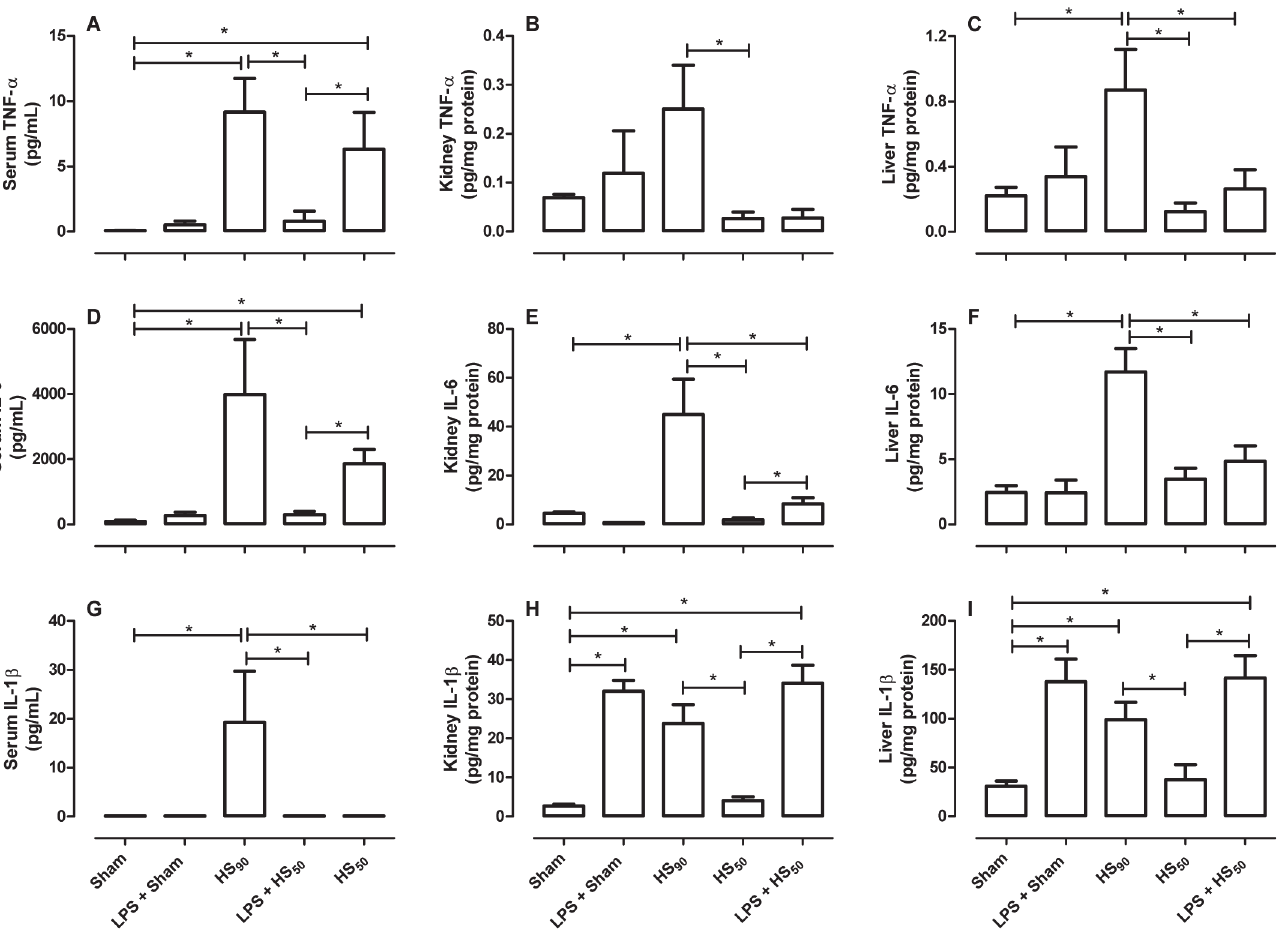
Fig 6. Effect of LPS preconditioning on cytokines production. Rats were injected vehicle (PBS) or LPS (1 mg/kg) i.p. 24 h prior to HS 90 or HS 50 . Sham animals were used as control. Four hours after resuscitation, serum (A, D, G), kidney (B, E, H) and liver homogenates (C, F, I) were obtained for TNF- α (A-C), IL-6 (D-F) and IL-1 β (G-I) determination by ELISA. Data are expressed as mean ± SEM of 6 – 8 animals. Statistical analysis was performed using one-way ANOVA followed by Bonferroni ’ s post hoc test. * p < 0.05 among the